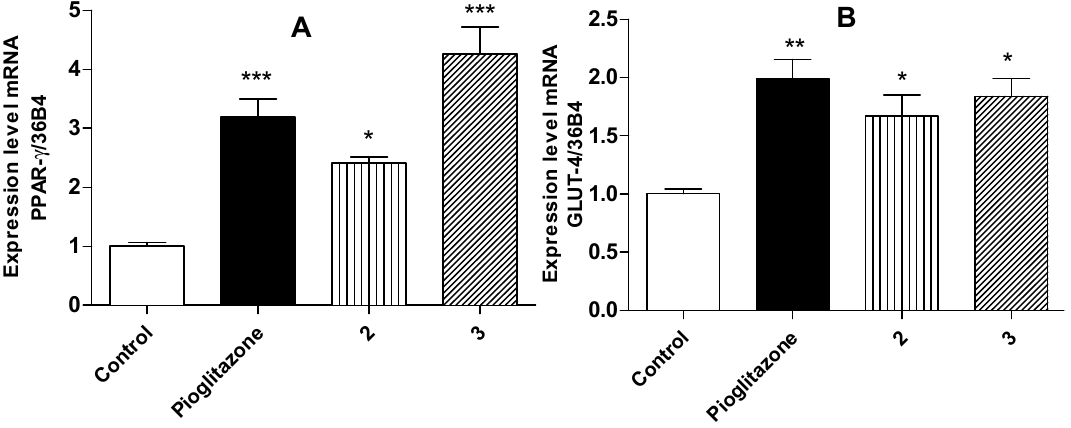
Figure 2. ( A ) Effect of compounds 2 and 3 on expression level of PPAR γ ; ( B ) Effect of compounds on expression level of GLUT-4. Results are mean ± SEM ( n = 6)/*** p < 0.001; ** p < 0.01; * p < 0.05 compared with control group.